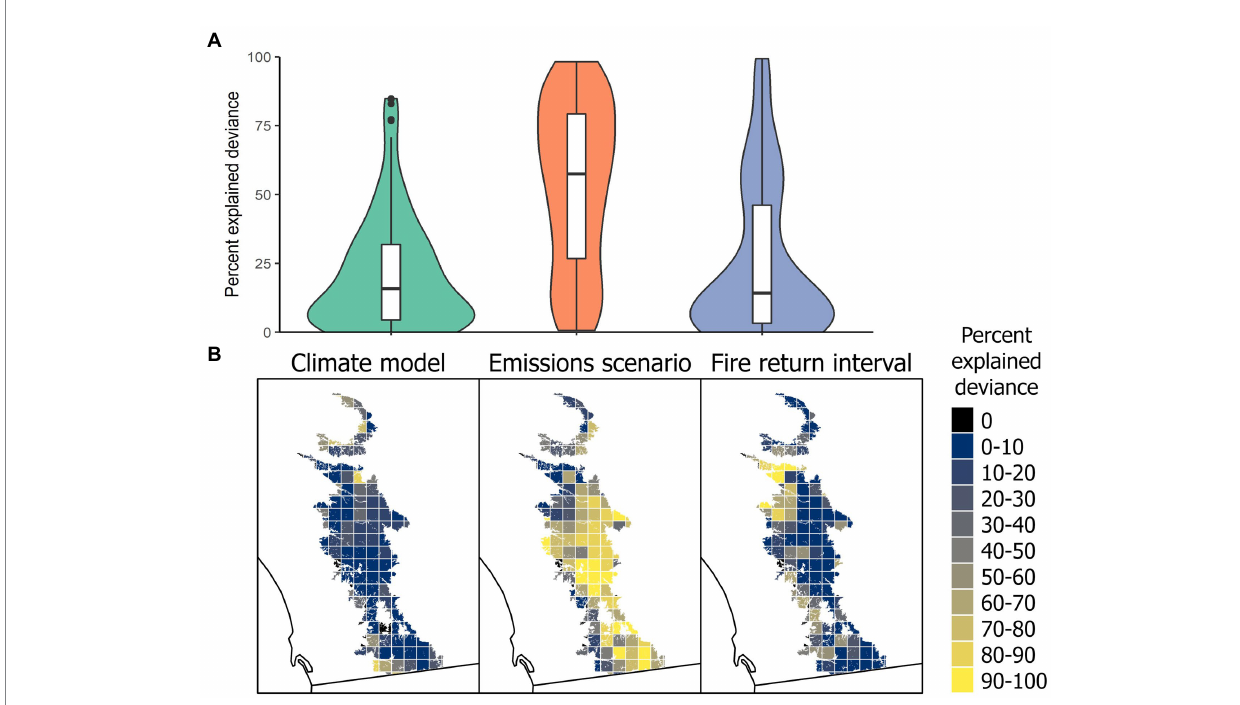
FIGURE 5 Percent deviance of each independent variable in explaining the relative final abundance of each subpopulation relative to the initial abundance of the subpopulation under spatially explicit fire return intervals. (A) Distribution of explained deviance among all subpopulations and independent variables. (B) Spatial representation of explained deviance from independent variables across the estimated range of C. perplexans (excluding 15 small subpopulations outside of this map in the